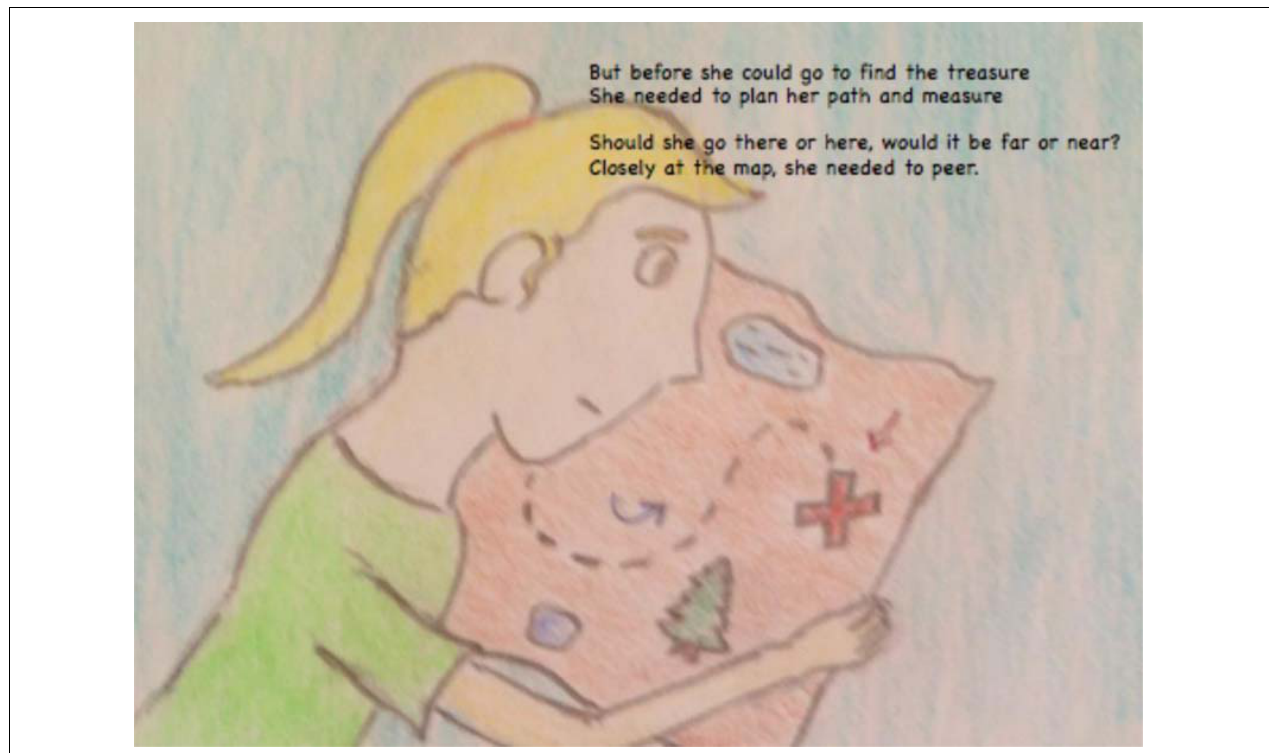
FIGURE 1 | Example page from the storybook with text from the rhyme